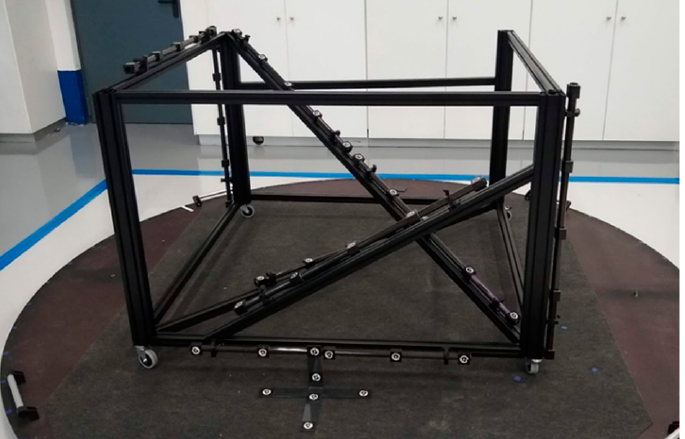
Figure 1. An arrangement of the reference scale bars for testing optical 3D measuring systems in accordance with VDI/VDE 2634 Part 1.